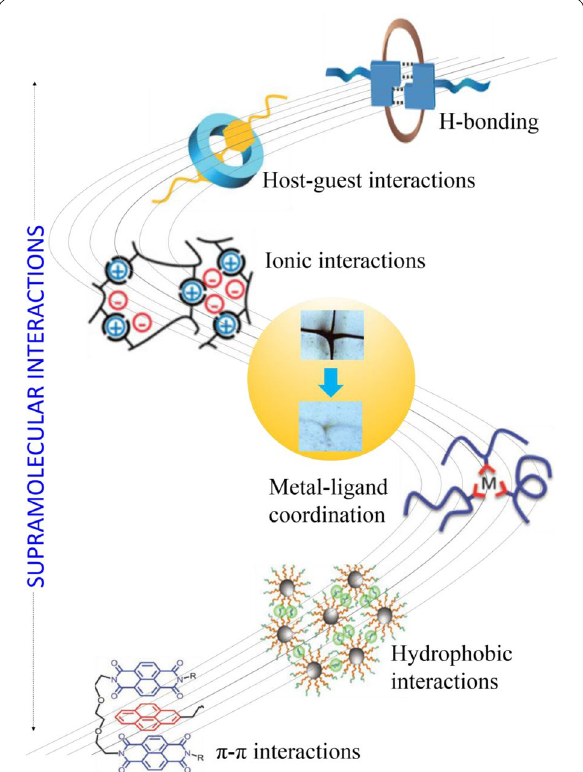
Fig. 1 Chemical strategies utilizing supramolecular chemistries for the design of self-healing functional materials, including dynamic covalent bonds and non-covalent interactions (Self-healing optical images: reproduced with permission from: Ref. [90], ©2018 AAAS. Host–guest, metal-coordination and π–π interactions images: reproduced with permission from: Ref. [59], ©2018